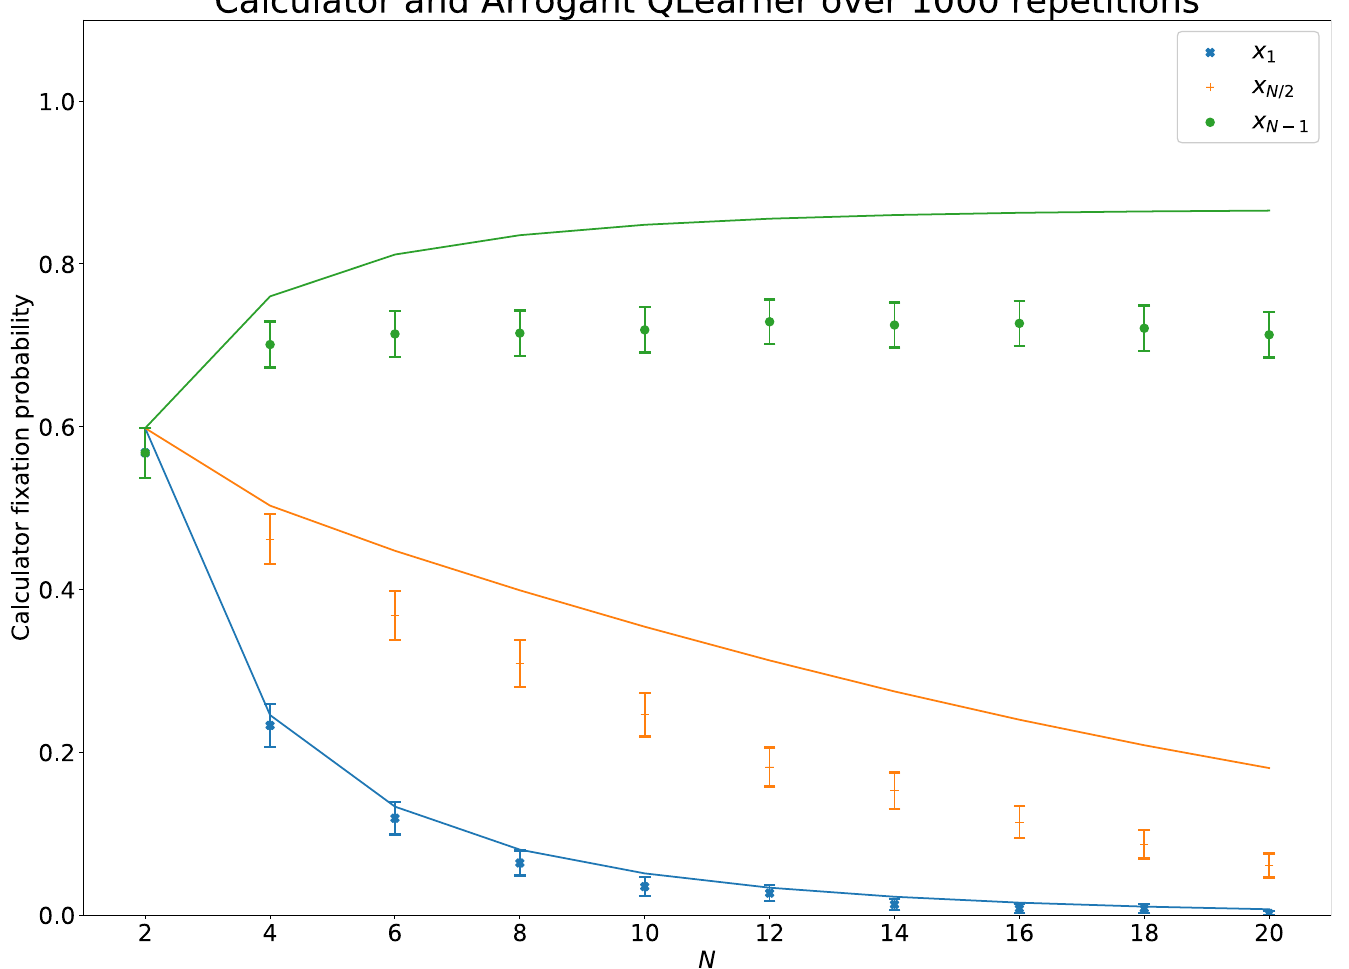
Fig 6. Comparison of theoretic and actual Moran process fixation probabilities for stochastic strategies: Calculator and Arrogant Q Learner. 5% confidence intervals calculated using an asymptotic normal approximation. The top most line on all figures (in red and using a circle) corresponds to x green and using a cross) corresponds to x N /2 and the bottom line (in blue and using an x) corresponds to x 1 .